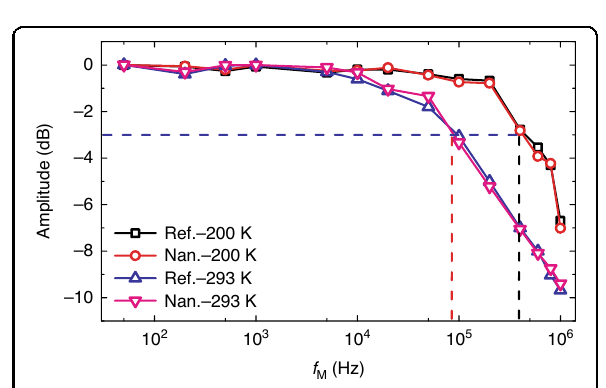
Fig. 6 Response bandwidth. Amplitude – frequency response of the devices at 293 and 200